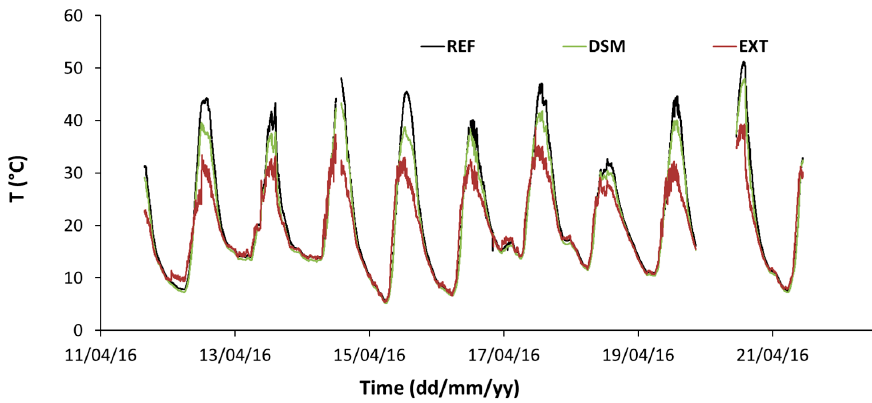
Figure 7. Temperature trends of air temperature inside reference (REF) box and DSM box compared to the external air temperature.